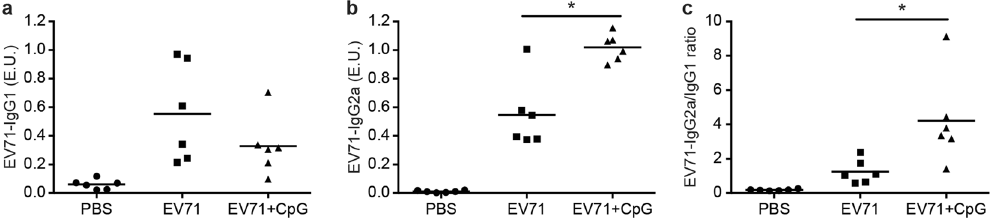
Figure 3. EV71-specific IgG1 and IgG2a responses in the serum. Effects of CpG as an adjuvant on EV71- specific IgG1 ( a ), EV71-specific IgG2a ( b ), and EV71-specific IgG2a-to-IgG1 ratio ( c ) in the serum of BALB/c mice at 2 weeks after the third immunisation with PBS or with formalin-inactivated EV71 alone or with CpG. Values shown are means ± SEMs of six mice in each experimental group; * p < 0.05. One representative study of three with similar results is